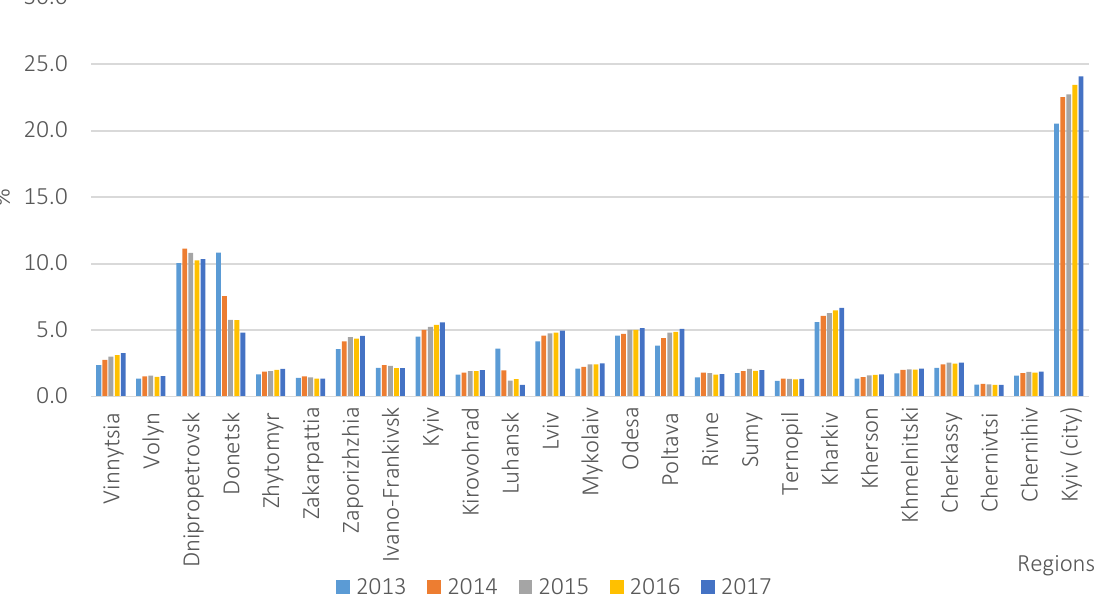
Note: Compiled based on Державна служба статистики України [Derzhavna sluzhba statystyky Ukrainy] (n.d.). Figure 3. Dynamics of the share of regions in the gross regional product of Ukraine in 2013–2017